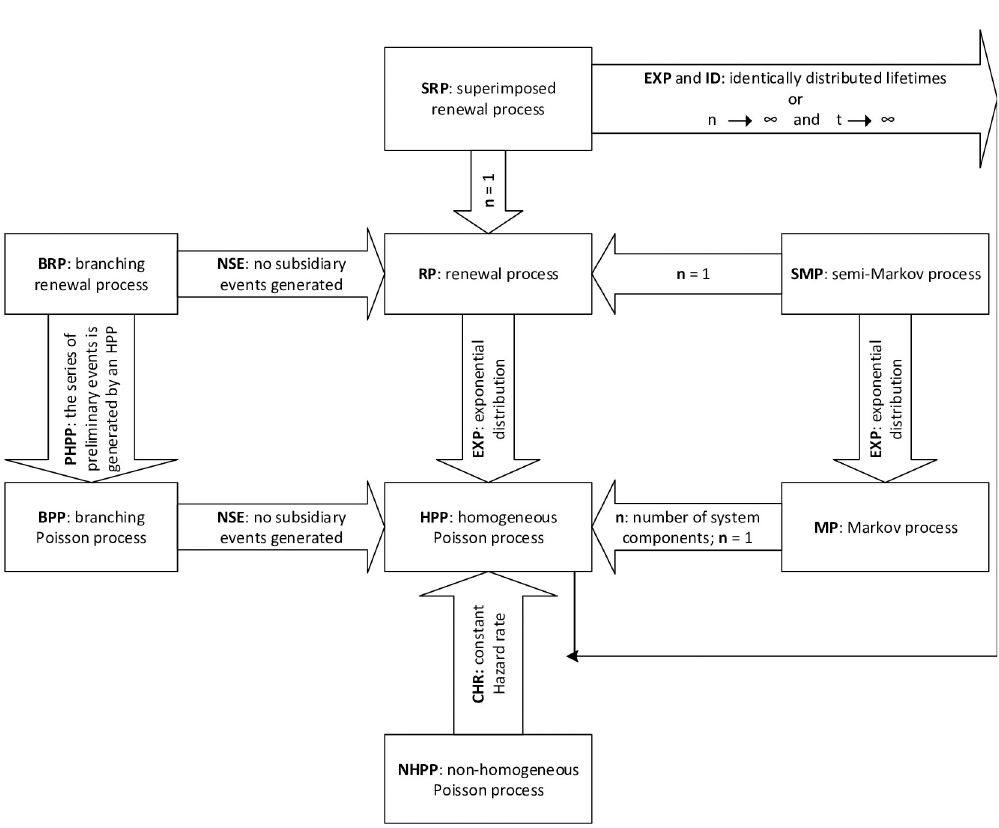
Fig 2. The relationship between classical statistical methods; reprinted from Pijnenburg [19].